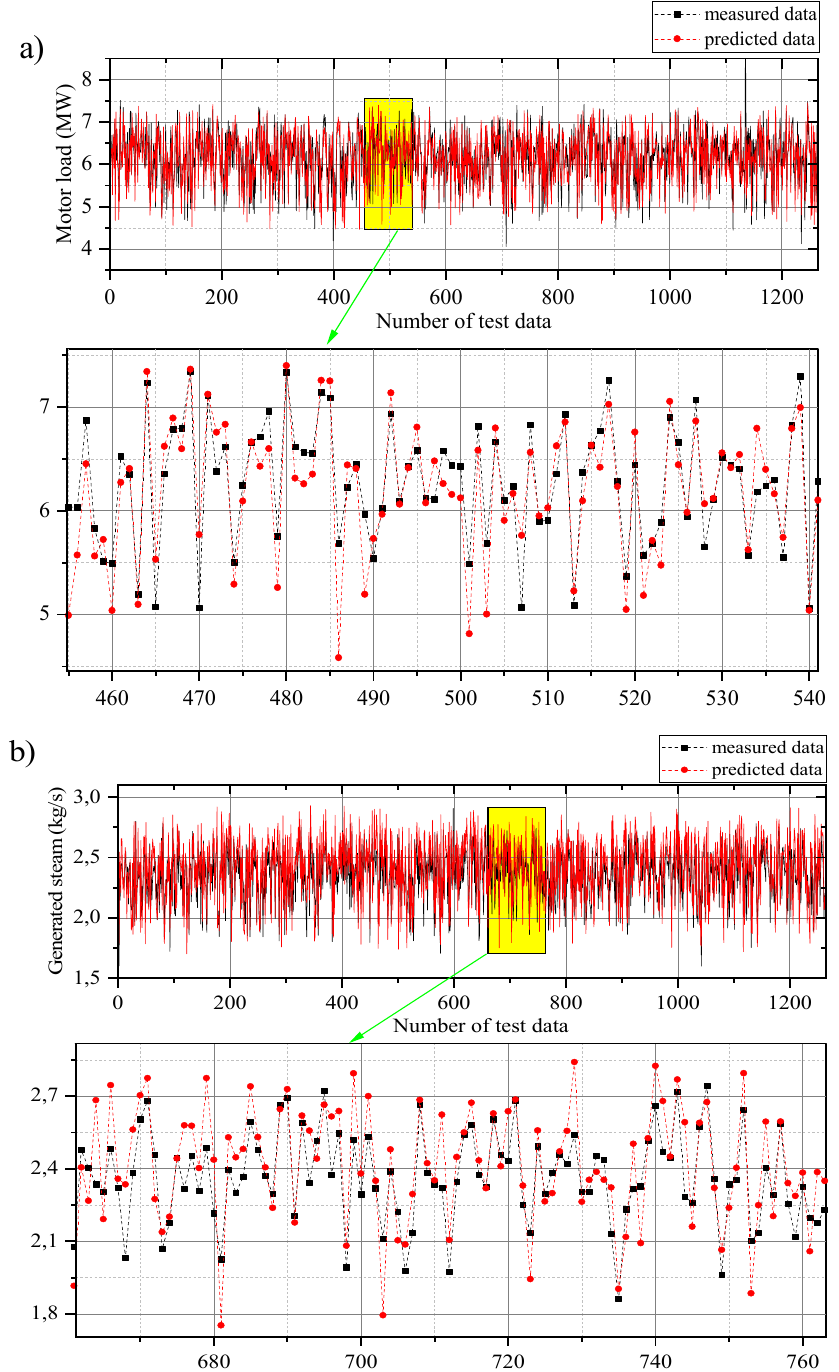
Figure 14. Test samples of TLBO to estimate motor load ( a ), and generated steam during the pulp refining process ( b ). Figure 15 delineates the measured data and predicted data for the model PSO-based model testing phase. The model results in a low root mean squared and squared error. The controlling parameters for the PSO algorithm are: inertia weight = 1, personal learning coe ffi cient = 1, global learning coe ffi cient = 2. This model predicted the targets (for the test samples and respectively for motor load and steam generation with RMSE of 0.2712 MW and 0.1131 kg/s; MSE of 0.0735 MW 2 and 0.0128 kg 2 /s 2 ; and R of 0.9052 and